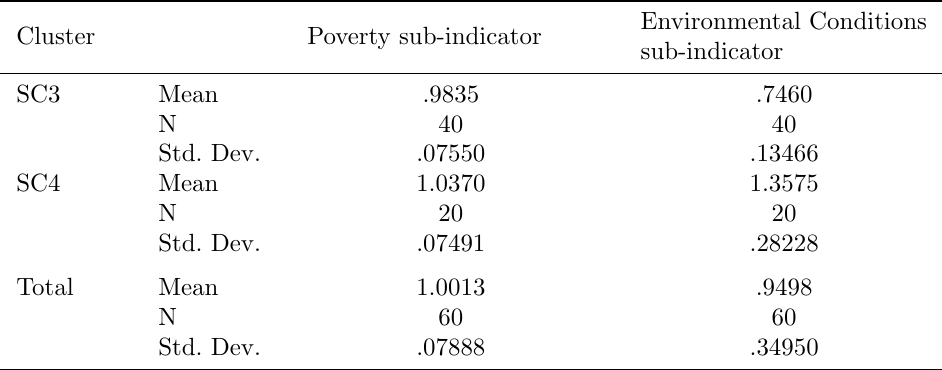
Table 10: Summary Report of the clustering based on the regions’ poverty and environ- mental characteristics